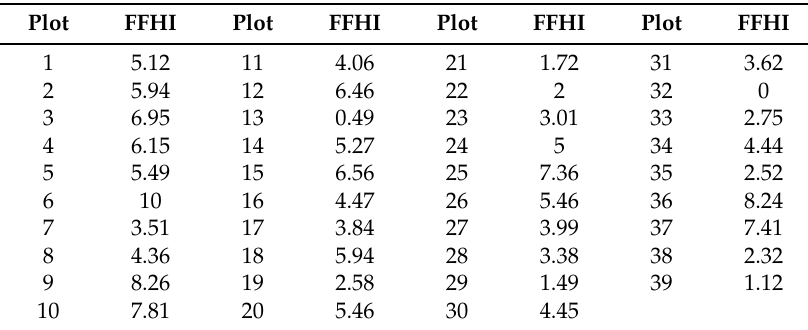
Table 6. Final forest health indicator (FFHI) for each